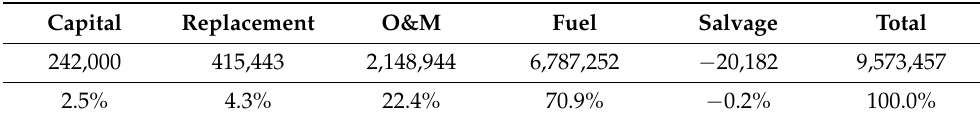
Table 6. Cost structure of topology_A (unit: USD).